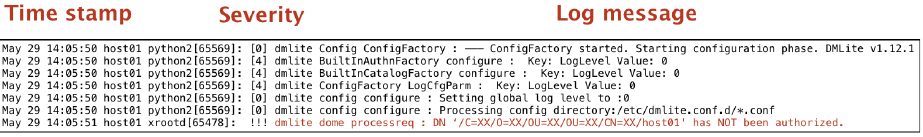
Figure 1: An example of DPM